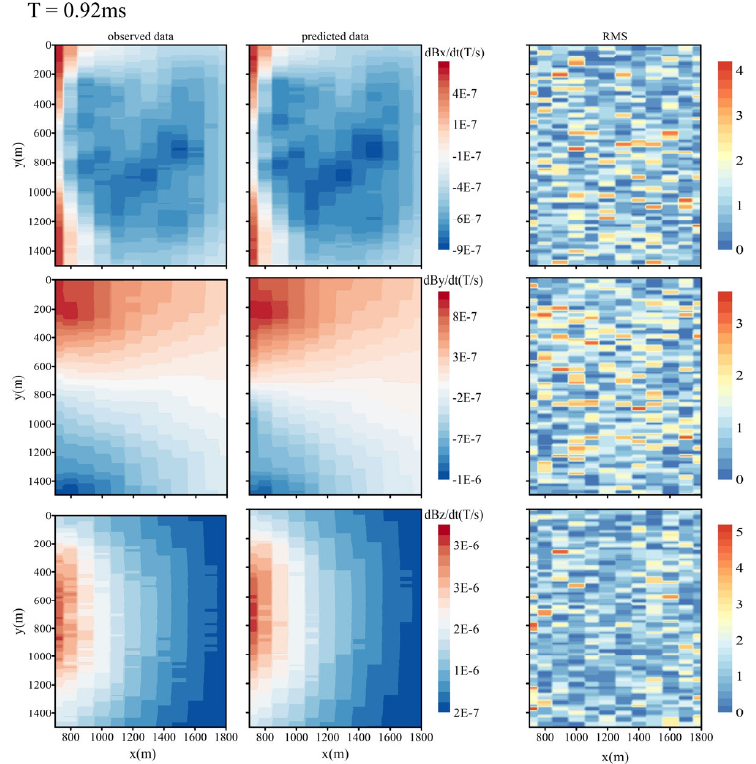
Figure 14. Data fitting of multi ‐ component inversion for the sulfide ore body model.